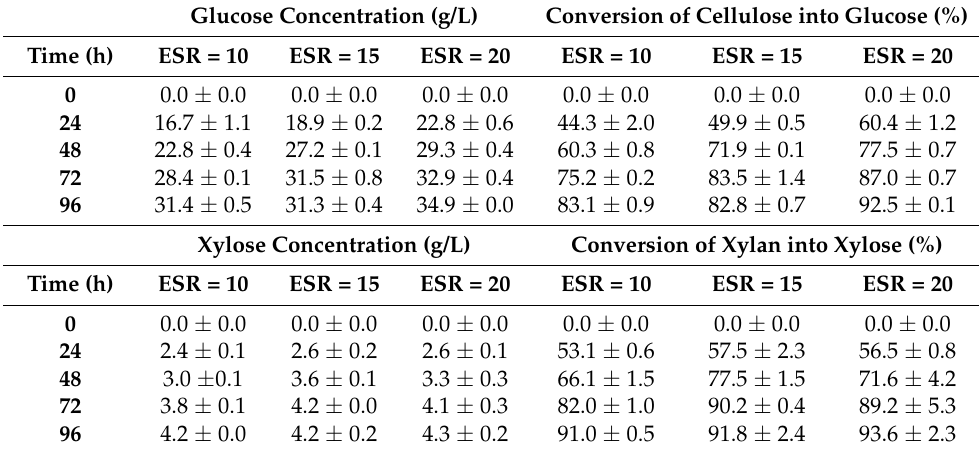
Table 2. Results achieved in the enzymatic hydrolysis of solids from the fractionation stage (PSO). The concentrations of glucose and xylose are expressed as g/L ± standard deviation. The conversions of cellulose and xylan into glucose and xylose are expressed as % ± standard deviation. Glucose Concentration (g/L) Conversion of Cellulose into Glucose (%)